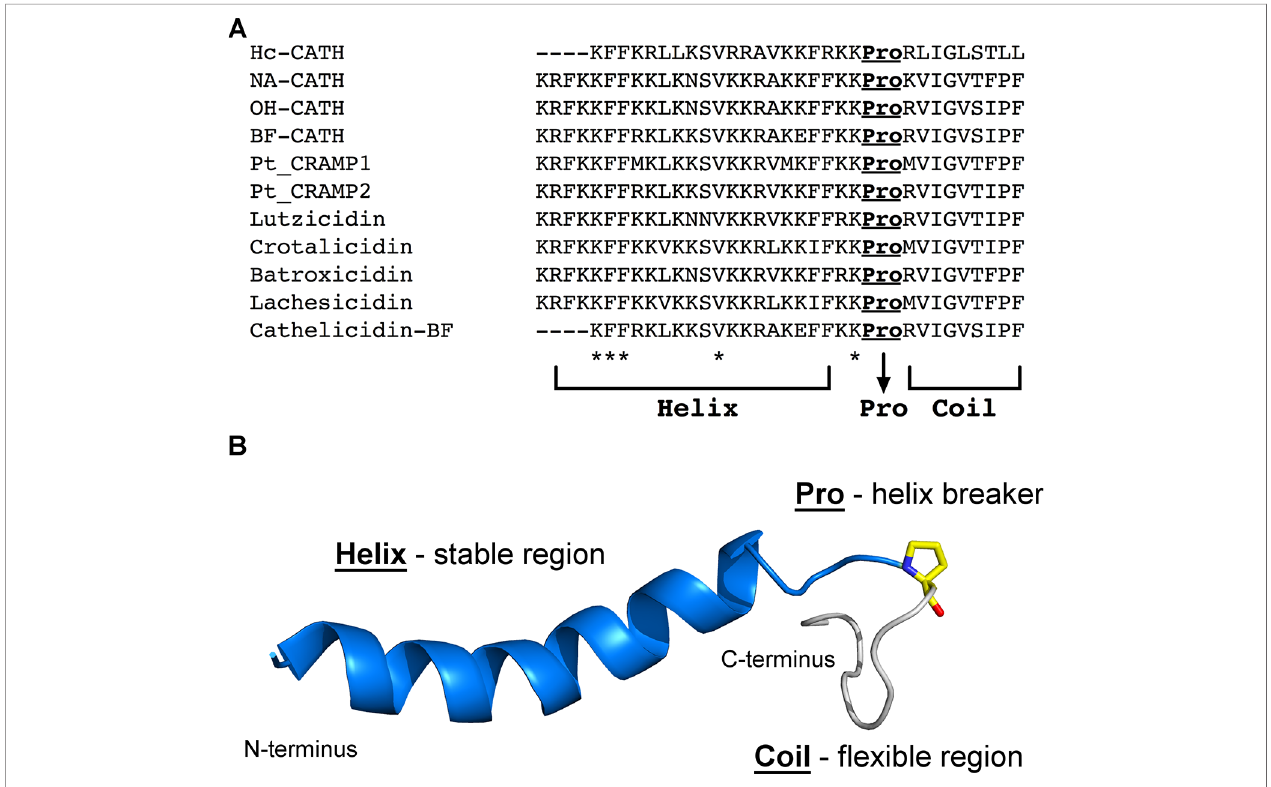
FIGURE 3 | Representation of the helix-Pro-coil structural pro fi le that has been described for snake venom CRAMPs. (A) , Sequence alignment highlighting a conserved proline residue at the C-terminus region of all snake venom CRAMPs here described. *Indicates conserved residues between all sequences. (B) , Lowest free energy structure obtained by solution NMR for crotalicidin (PDB entry: 2mwt) (Falcao et al., 2015). Although the two lysine residues that precede the proline appear unstructured, they are structurally stable among the 20 lowest free energy structures deposited for crotalicidin. In contrast, the residues after the proline are highly fl exible. The proline residue is represented as yellow